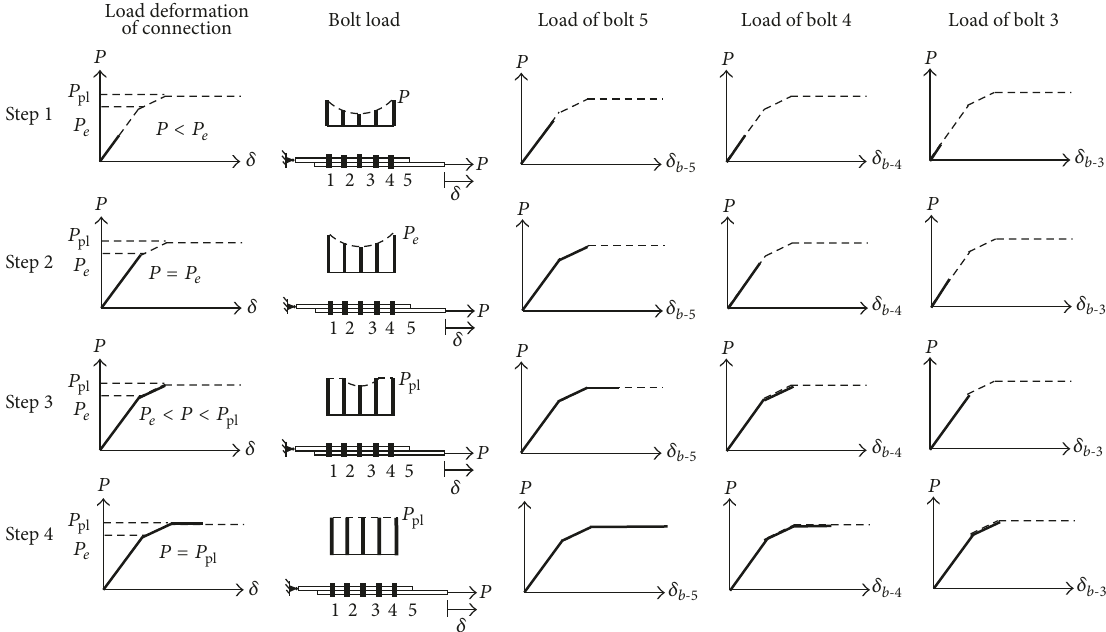
Figure 1: Stages of force distribution in bolt connections